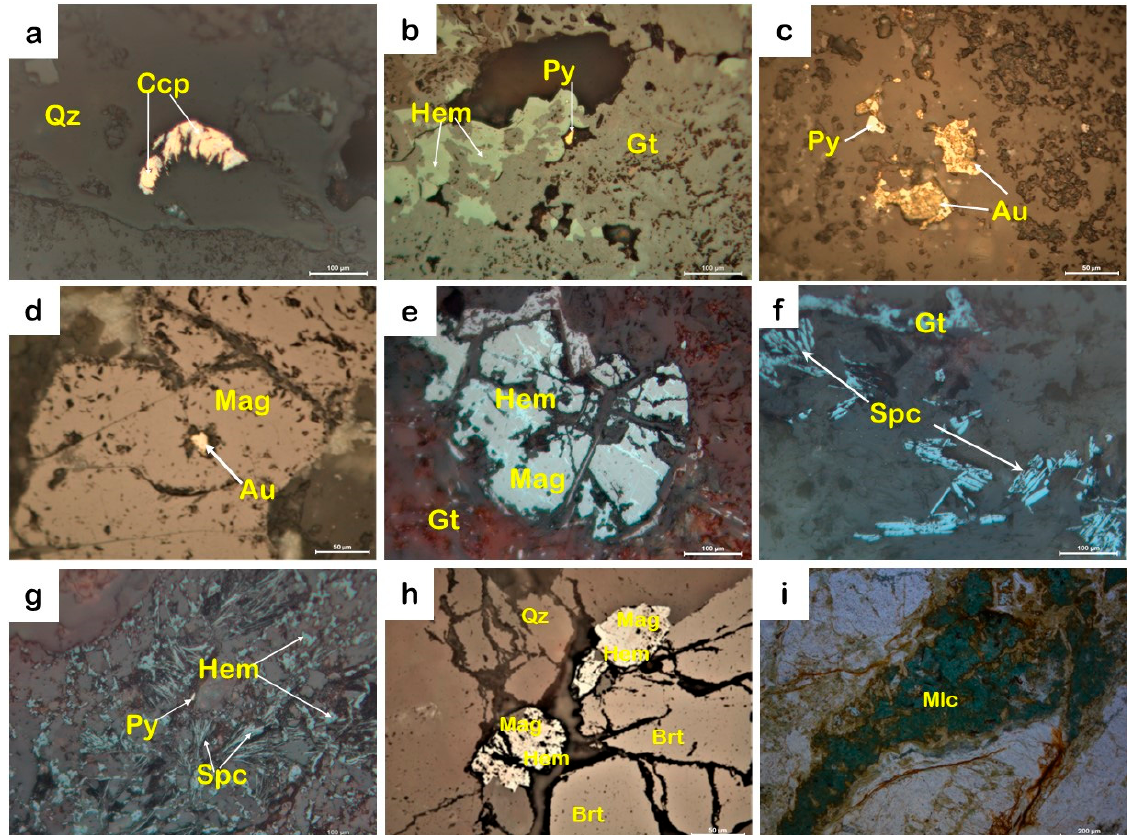
Figure 9. Photomicrographs of the different ore minerals: ( a ) Chalcopyrite (ccp) occurred at quartz vein. ( b ) Pyrite (py) is highly altered to goethite (gt) associated with hematite (hem). ( c ) Free gold (Au) grains with pyrite (py) disseminated along the alteration zone-1. ( d ) Gold (Au) is associated with magnetite (mag). ( e ) Magnetite (mag) crystal is partially pseudomorphic and transformed into hematite (hem) (martitization). ( f , g ) Specularite (spc) associated with hematite (hem) and goethite (gt). ( h ) Barite (brt) is associated with magnetite (mag) and hematite (hem). ( i ) Malachite (mlc) pseudomorph after